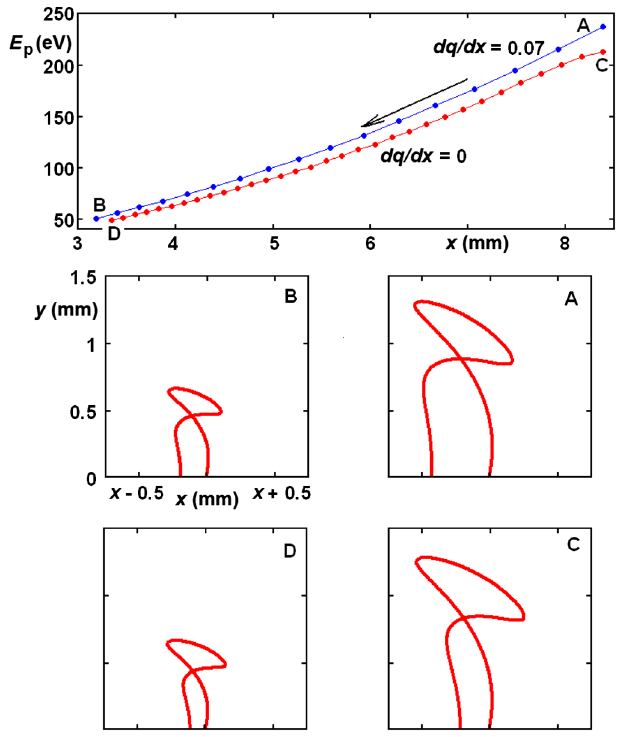
FIG. 10. Coordinates of the impact points for the electrons started at the curvature beginning point. Influence of the nonzero dq=dx . Trajectories in the extreme points A, B, C, and D are shown in the same